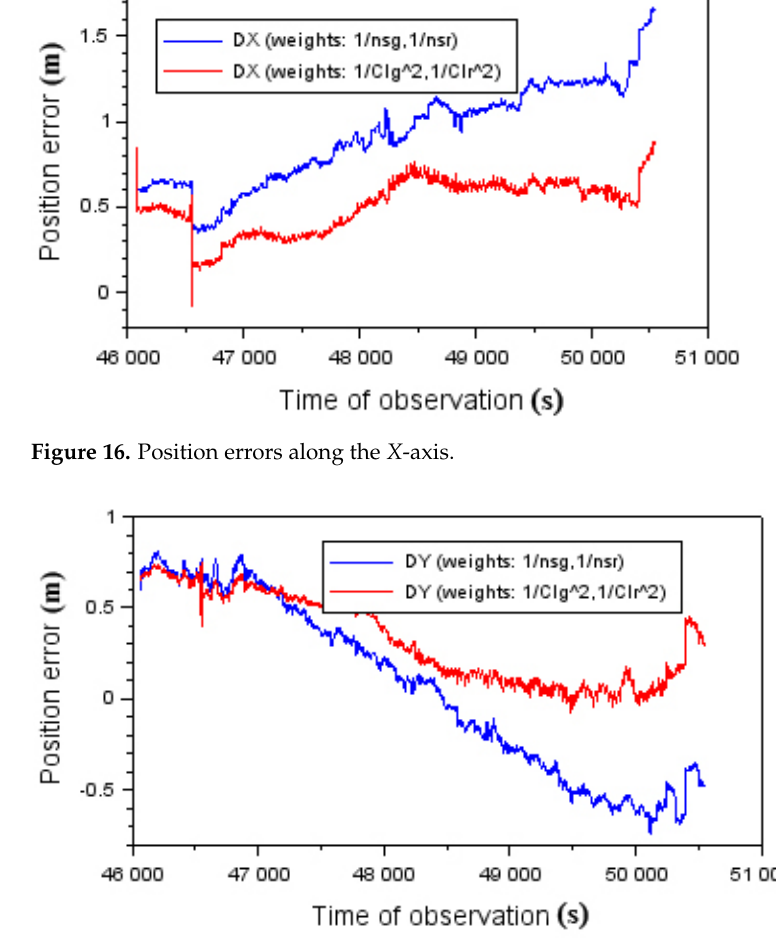
Figure 17. Position errors along the Y -axis.